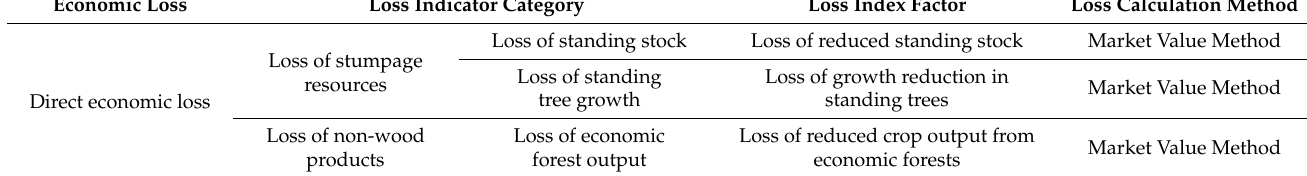
Table 3. Evaluation index system and calculation method for forest economic losses caused by